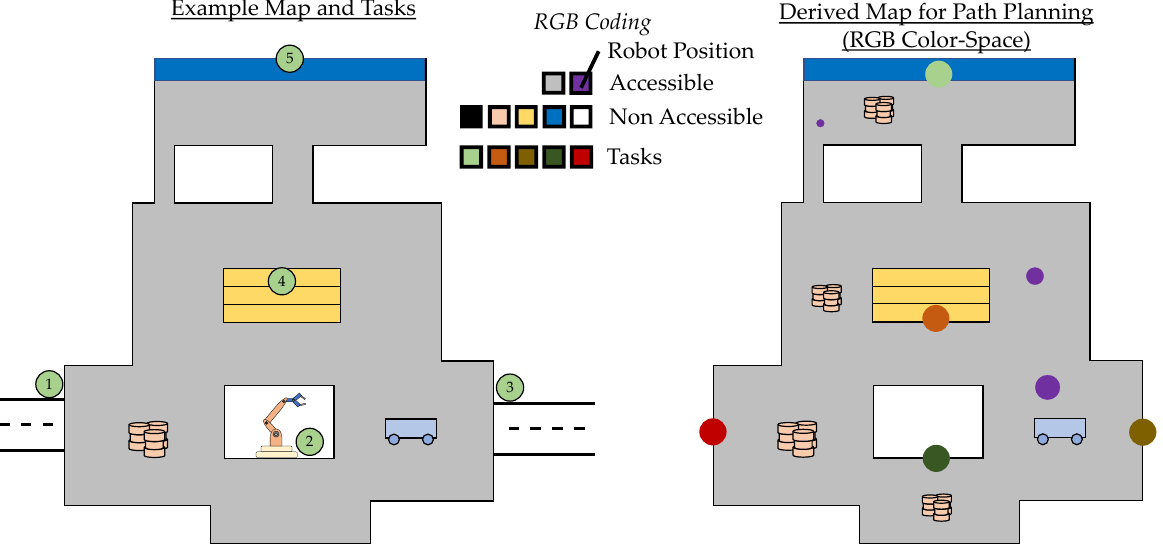
Figure 8. Task 1-5, robots, and paths based on RGB map: original map, derived RGB-coded map. The map is coded as an RGB image. Here, the different tasks are each marked with their own color. In the following, the skeletonization described above is applied to this